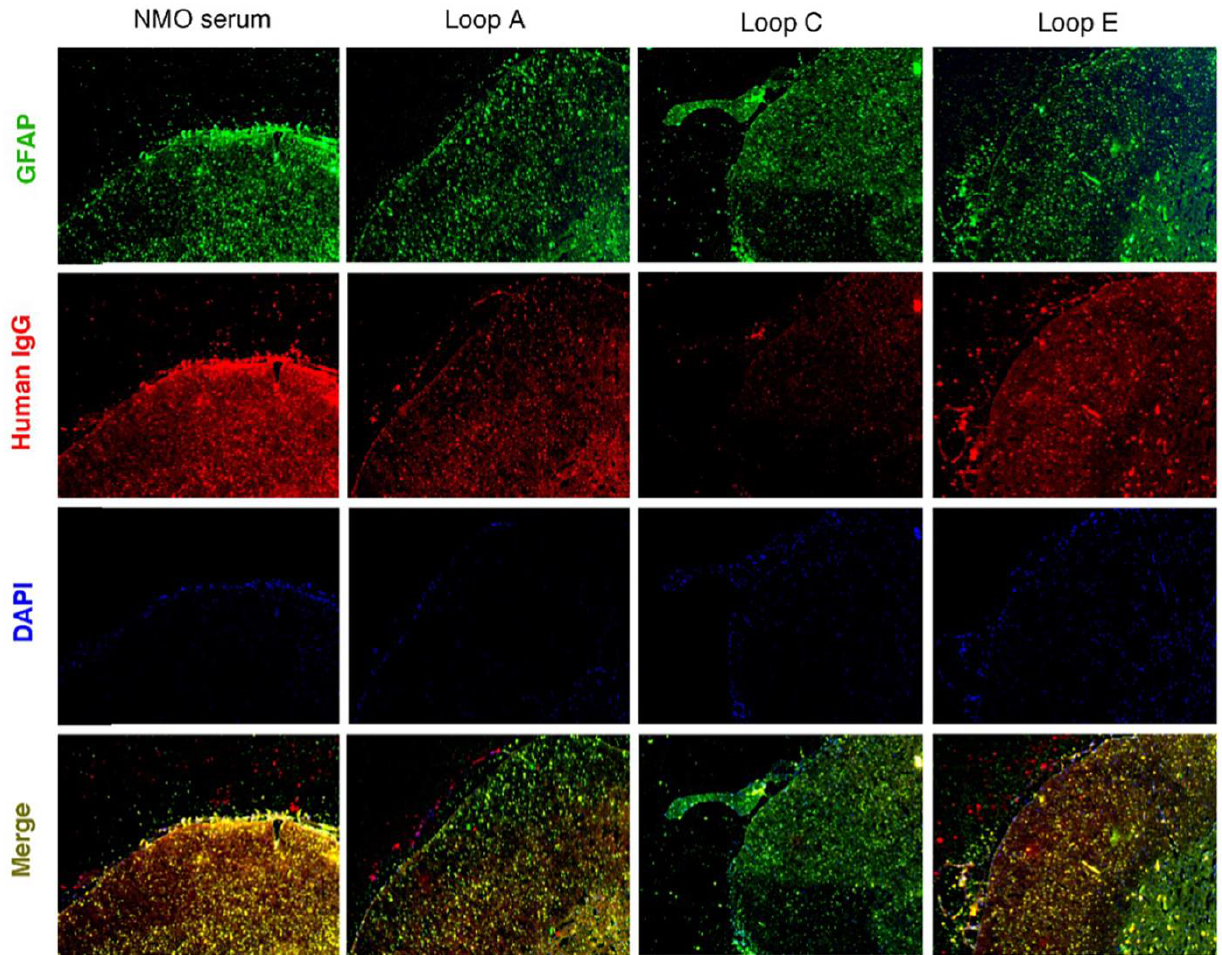
Figure 2. AQP4 extracellular mimotope peptides interrupted serum binding from NMOSD patients to rat spinal cord tissue.